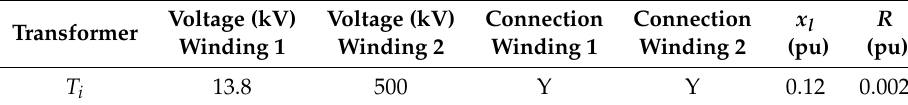
Table A6. Transformers